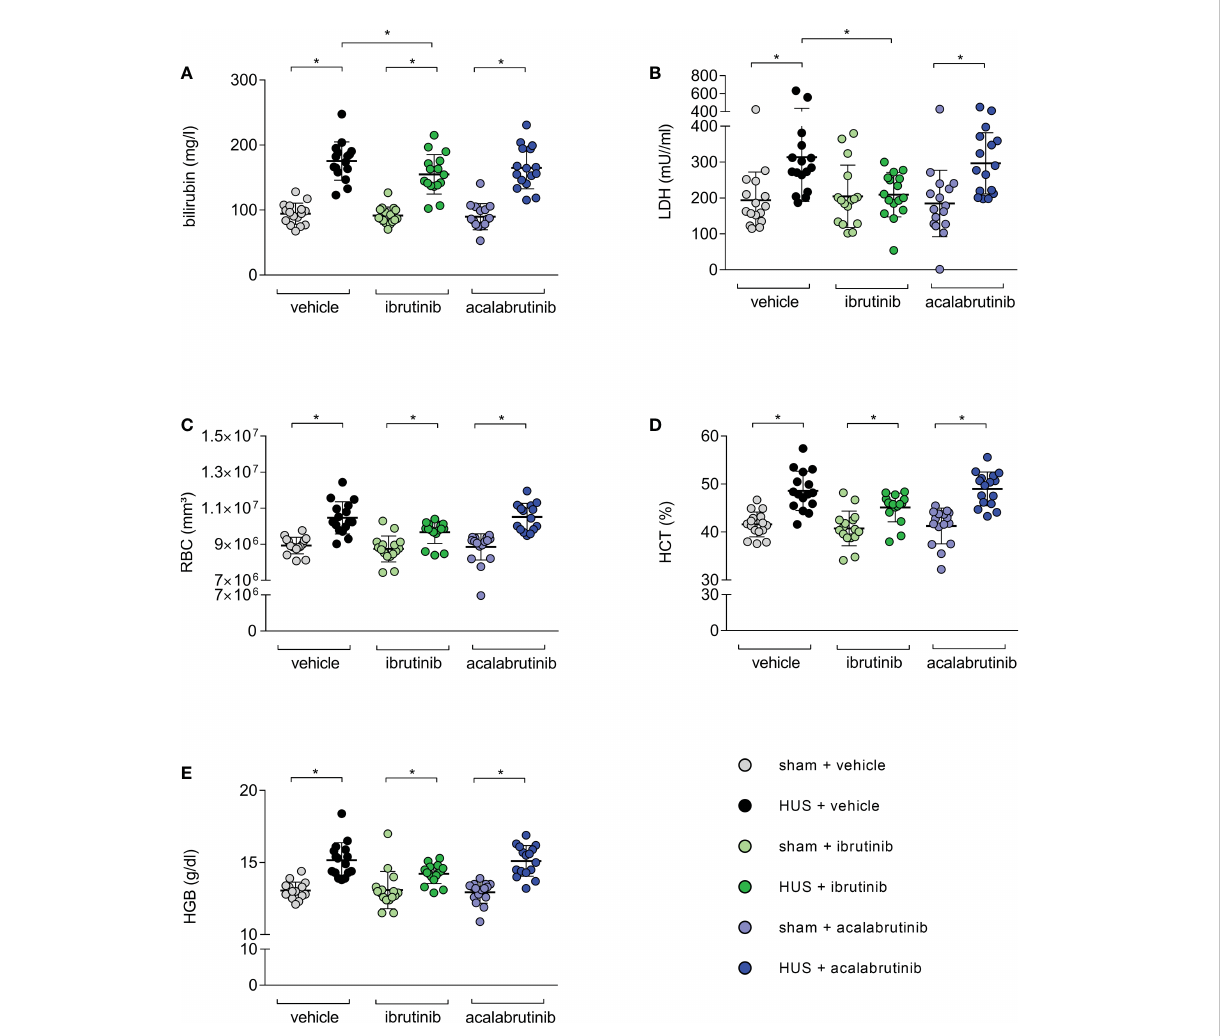
FIGURE 3 Surrogate parameters of hemolysis of mice with HUS treated with ibrutinib or acalabrutinib. Determination of plasma (A) bilirubin; (B) LDH activity and whole blood (C) erythrocytes, (D) hematocrit and (E) hemoglobin (n = 16 per group) on humane endpoint or day 7. Data are expressed as scatter dot plot with mean + SD. (A) ordinary one-way ANOVA + Holm-Sidak ’ s multiple comparison test, (B – E) Kruskal-Wallis test + Dunn ’ s multiple comparison test. *P < 0.05. RBC, erythrocytes; HCT, hematocrit; HGB, hemoglobin; LDH, lactate dehydrogenase; HUS, hemolytic-uremic